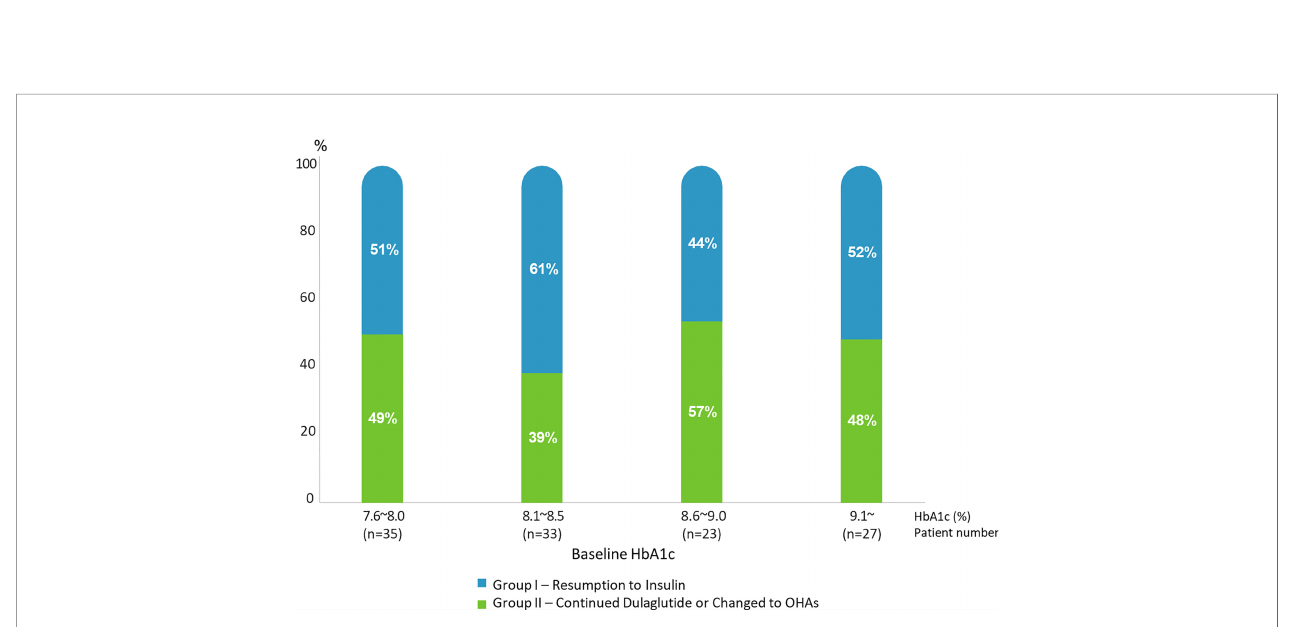
FIGURE 3 | Rates of Resumption to Insulin (Group I) and Continued Dulaglutide/Changed to OHAs (Group II) according to baseline HbA1c